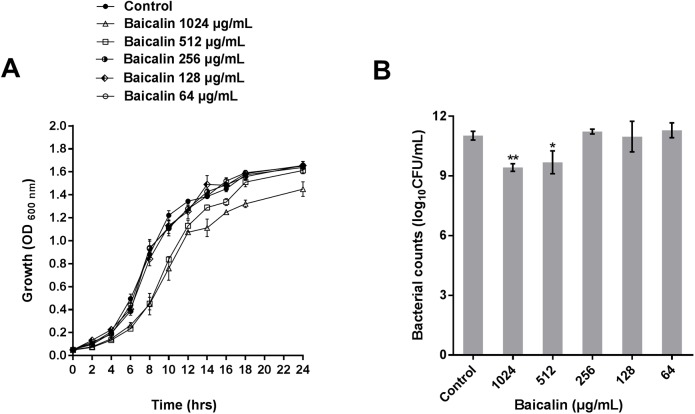
Effects of baicalin on the growth of P. aeruginosa PAO1.Growth curves (A) and bacterial colony counts (B) of P. aeruginosa PAO1 treated with varying concentrations of baicalin (64–1024 μg/mL) in Luria-Bertani broth at 37°C for 24 h. Experiments were performed in triplicate; the error bars represent the standard error of the OD600 value for each time point in the growth curves and the standard error for the number of CFUs after 24 h treatment. * and ** indicate P-values <0.05 and <0.01, respectively, with respect to the control (no baicalin).